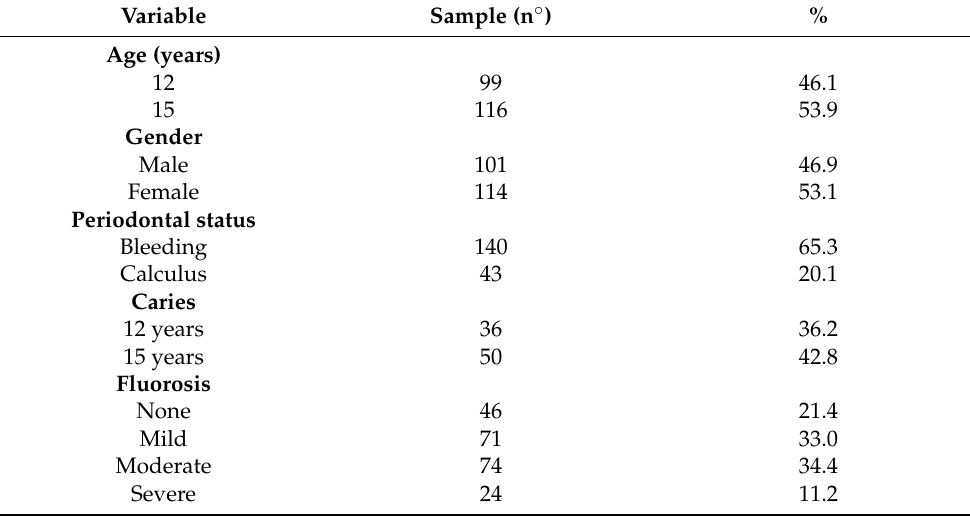
Table 1. Distribution according to age, gender, and oral health status.